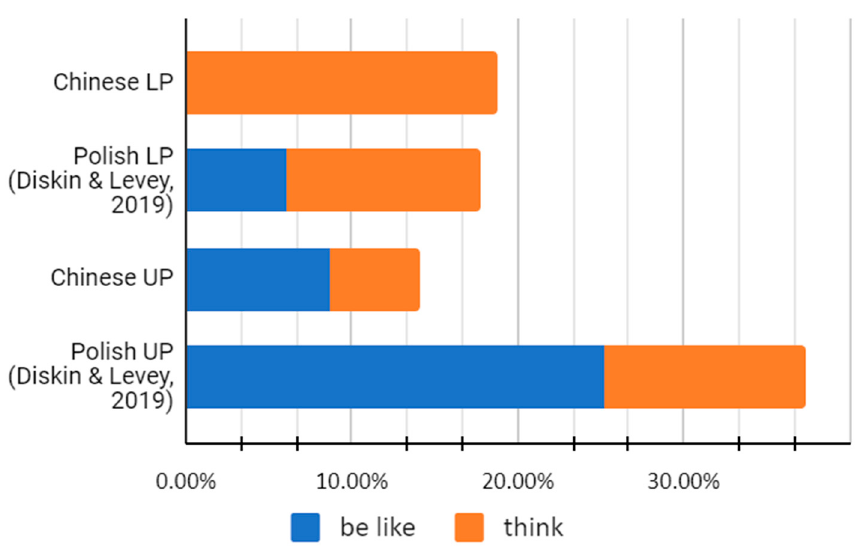
Figure 5. Comparison of be like and think among lower proficiency (LP) and upper proficiency (UP) speakers in the Chinese and Polish L2 corpora (Diskin and Levey 2019).